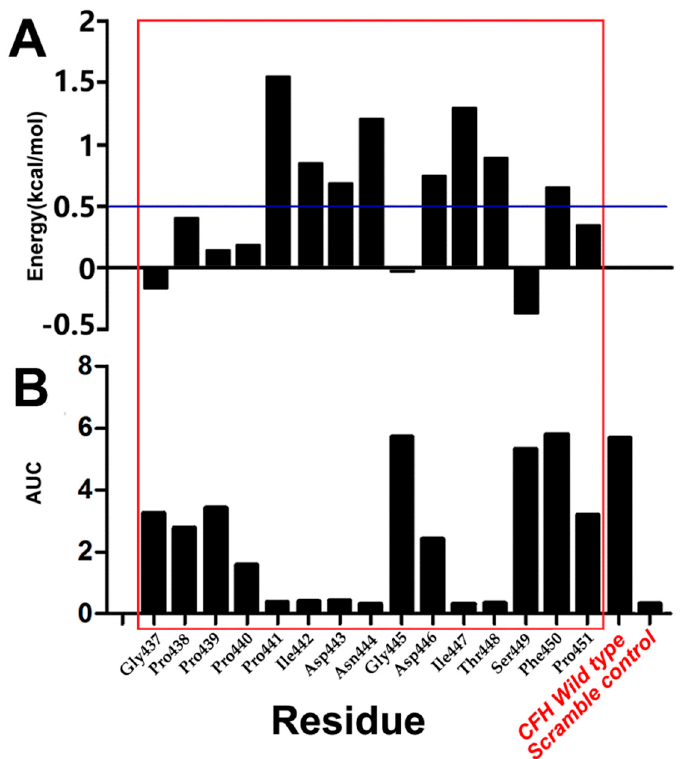
Figure 5. Results of computational alanine scanning (CAS) and experimental alanine scanning (EAS). ( A ) CAS, Pro441, Ile442, Asp443, Asn444, Asp446, Ile447, Thr448, and Phe450 had an energy of >0.5